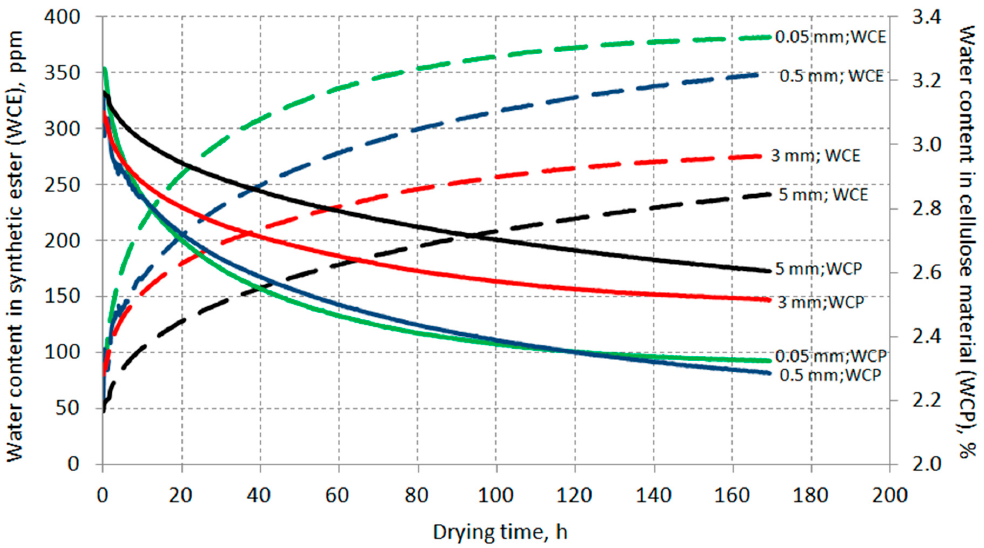
Figure 4. Water content in synthetic ester (WCE) and cellulose materials (WCP) during drying of paper and pressboard of different thickness, drying temperature equal to 70 °C.